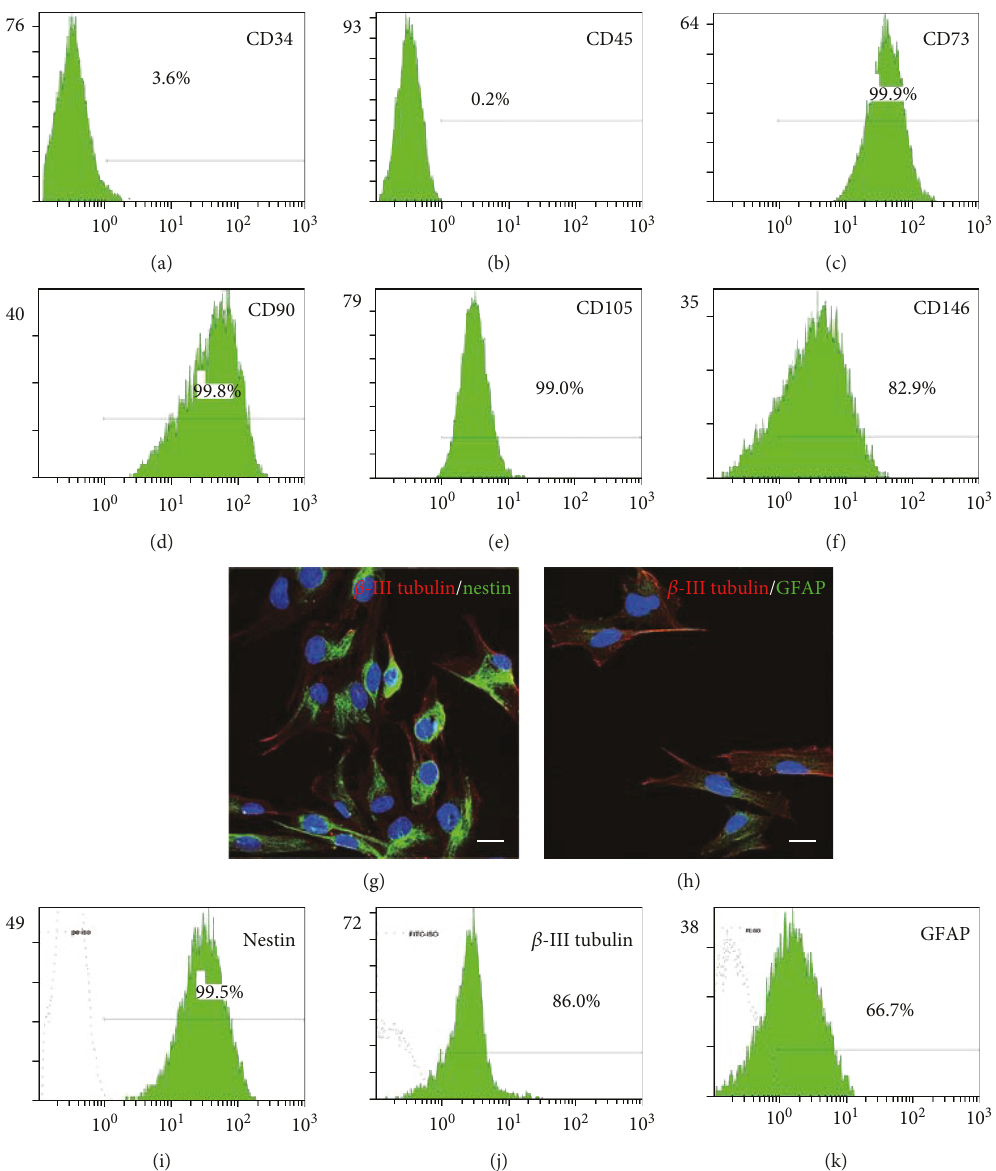
Figure 1: Identi fi cation of SHEDs. (a) – (f) Flow cytometry plots showing that the cultured SHEDs were positive for the mesenchymal markers CD73, CD90, CD105, and CD146, but negative for the hematopoietic marker CD34 and the common leukocyte antigen CD45. (g)-(h) Representative photomicrographs of SHEDs expressing the neural stem cell markers nestin and β -III tubulin, and the glia-speci fi c marker GFAP. Scale bars: 20 μ m. (i) – (k) Flow cytometry plots showing the percentages positive for nestin, β -III tubulin, and